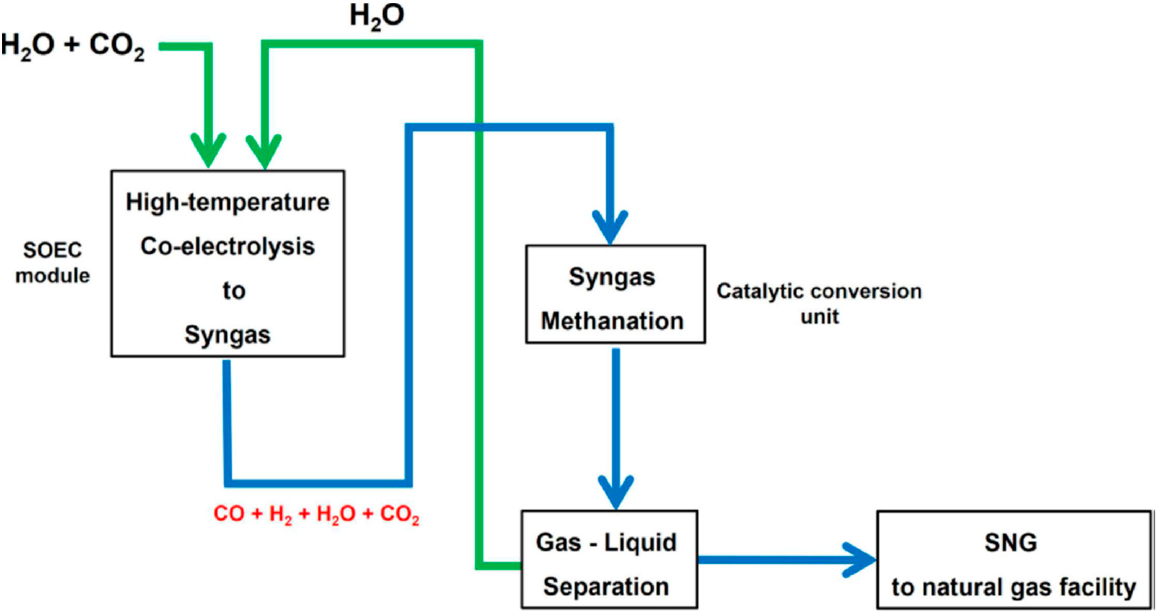
Figure 8. Integrated P2G process for synthetic natural gas (SNG) production from CO 2 and H 2 O. Adapted from ref. [89]. Copyright 2021 John Wiley and Sons.